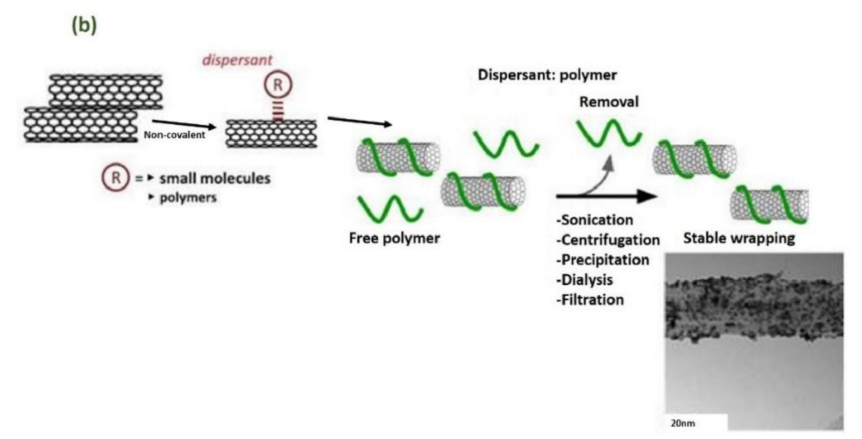
Figure 1. ( a ) The covalent functionalization phenomena at the side and end-caps of CNT structure (re- produced from [33]) and ( b ) non-covalent functionalization method for polymer wrapping (adapted from